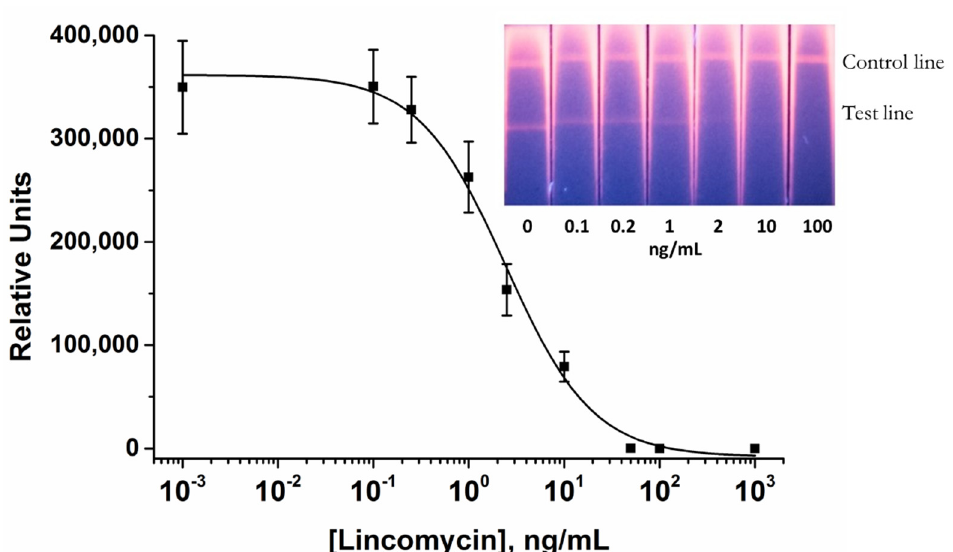
Figure 5. Calibration curve of LIN in the QD-based LFIA and image of the test strips with increasing concentration of LIN ranging from 0.1 to 100 ng/mL under following optimal conditions: The LIN-BSA conjugate was applied at the test line at a concentration of 0.15 mg/mL; 1 μ L of antibody–QDs conjugate (0.09 µ M) was applied to the interface of the sample pad and nitrocellulose membrane. The error bars indicate the standard deviations for three